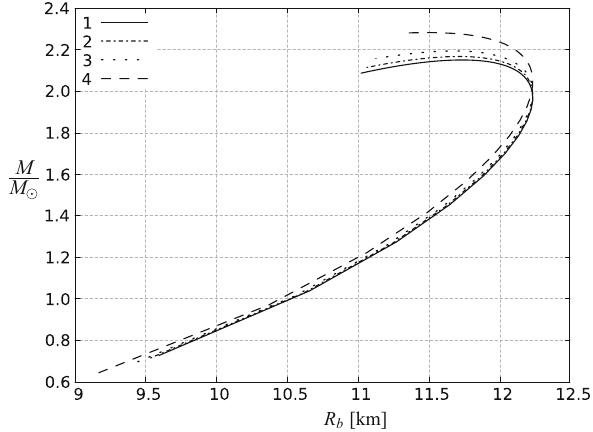
Fig. 5 Mass–radius relation for compact objects with LQG-inspired corrections and MIT-bag equation of state B = 50 MeV / fm 3 . The solid curve (1) shows the purely relativistic case. The dashed curve (2) is obtained for ρ cr = 10 17 g / cm 3 , the dotted curve (3) is obtained for ρ cr = 4 × 10 16 g / cm 3 , the dash-dotted curve (4) is obtained for ρ = 1 . 5 × 10 16 g / cm 3 cr